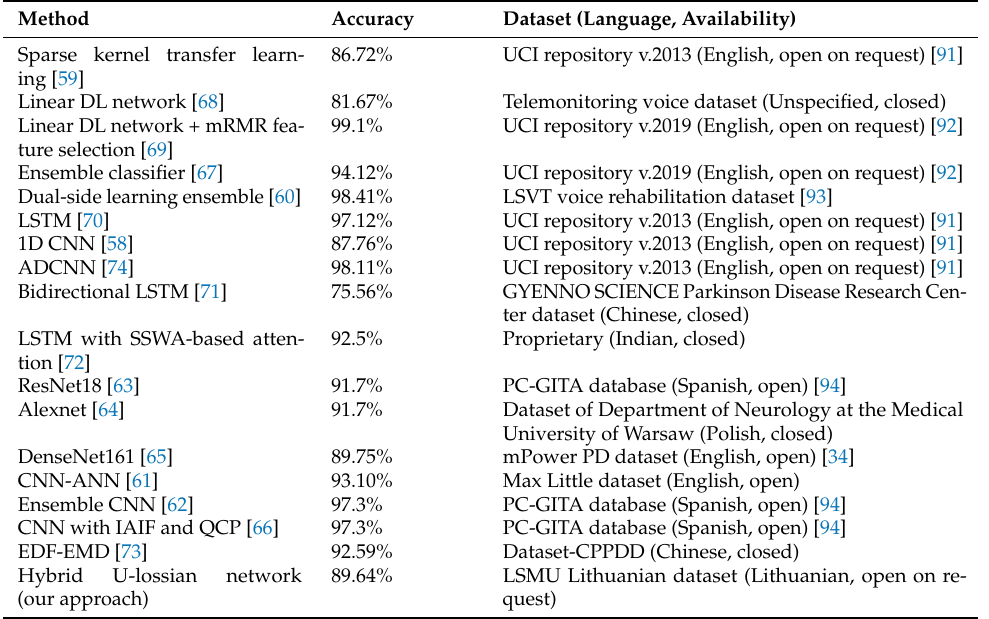
Table 4. Comparison of different methods of PD voice